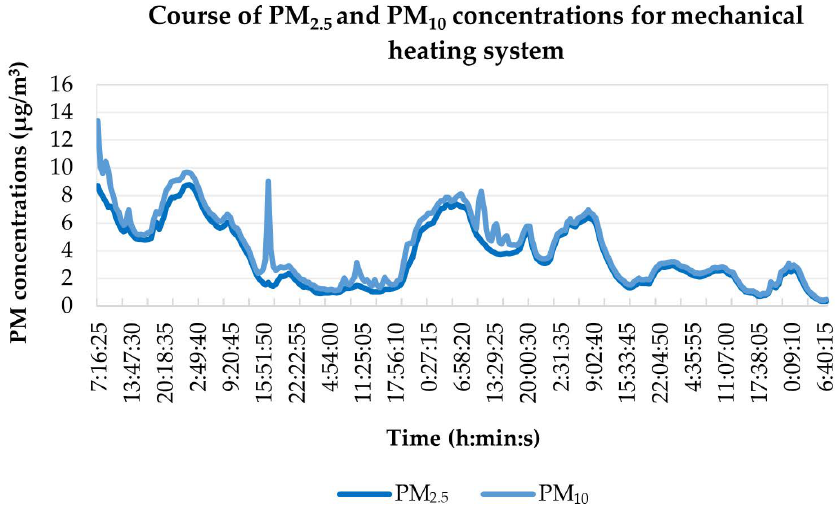
Figure 13. Courses of PM 2.5 and PM 10 concentrations for MHS.